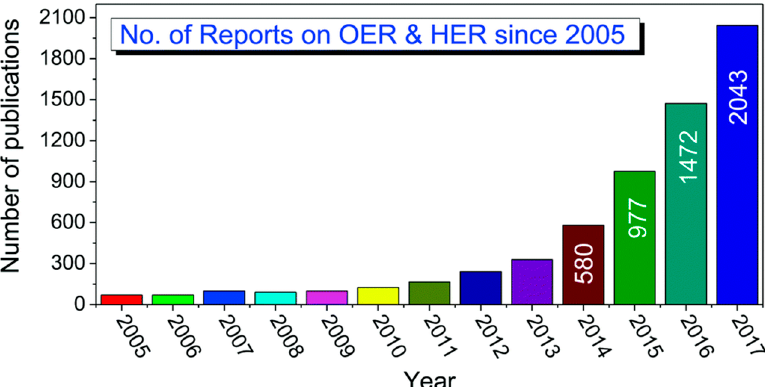
Figure 2. Histogram showing the number of scientific reports on OER and HER from 2005 to 2017. Reprinted with permission from [55]. Copyright 2018, The Royal Society of Chemistry.